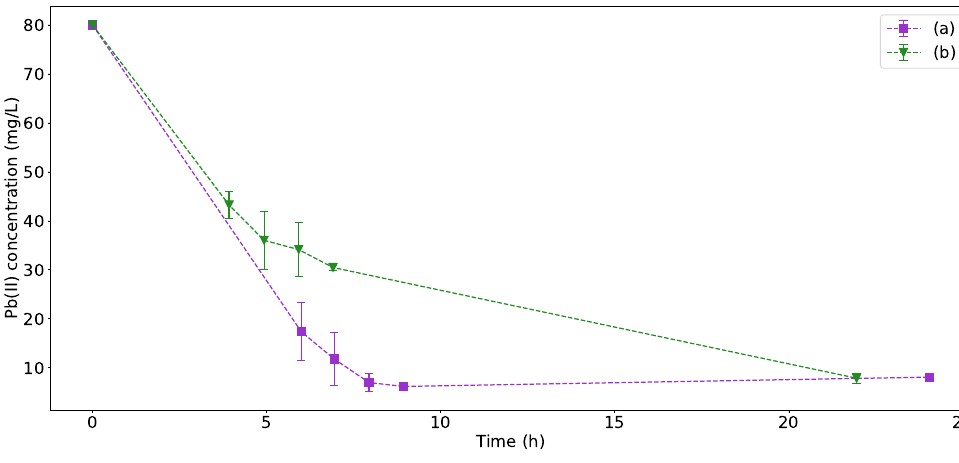
Figure 3. Residual Pb(II) concentration in reactors containing 80 mg/L initial concentration of Pb(II) with ( a ) P. bifermentans and ( b ) K. pneumoniae .